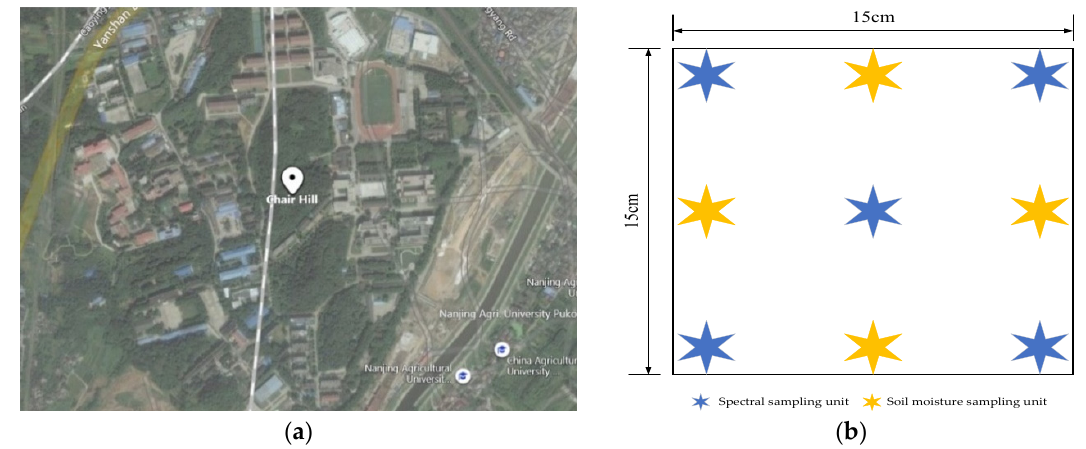
Figure 1. Location of the study area and distribution of sampling points: ( a ) location of the Chair Hill; ( b ) distribution of sampling points.